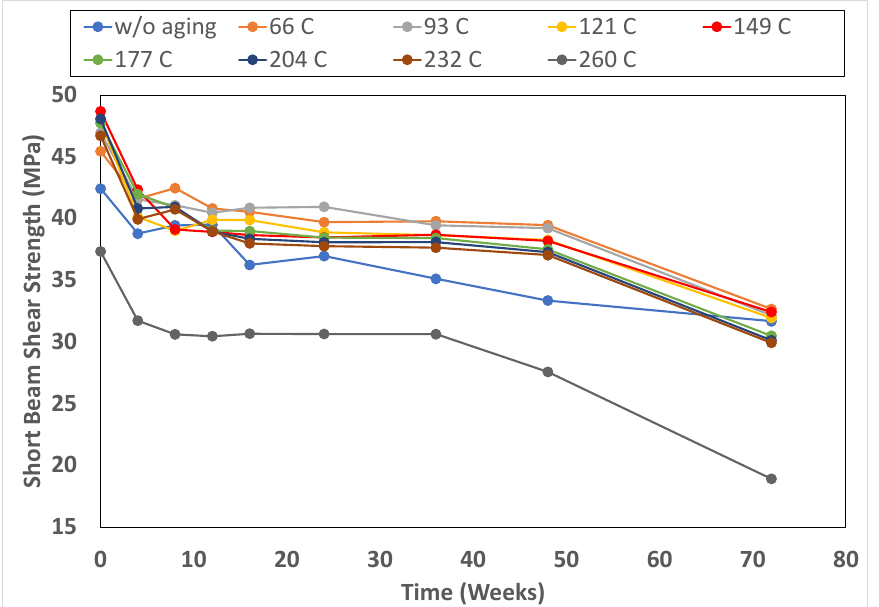
Figure 9. SBS strength as a function of time of immersion in deionized water and temperature of prior thermal aging for 8 h.